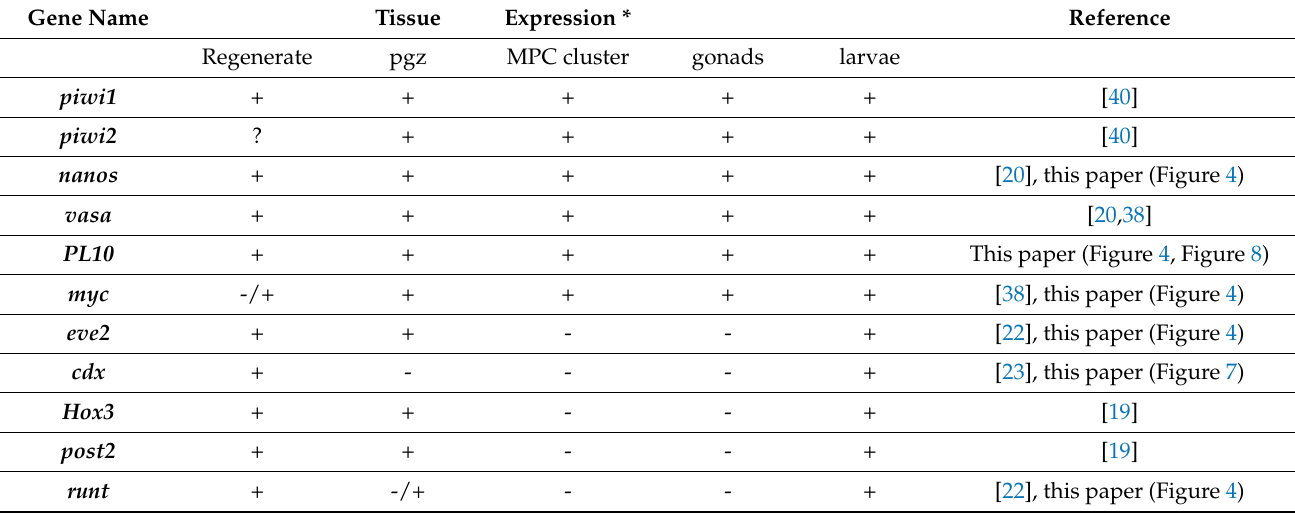
Table 1. Comparison of gene expression between regeneration, growth and development.